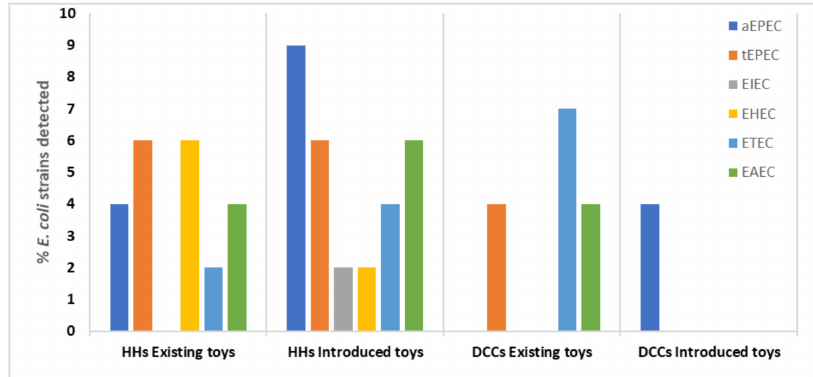
Figure 3. Prevalence of pathogenic E. coli strains found on existing and introduced toys (Excluding data from 2 DCCs who withdrew from study; Keywords: EAEC = enteroaggregative E. coli , aEPEC = atypical enteropathogenic E. coli , tEPEC = typical enteropathogenic E. coli , EHEC = enterohemorrhagic E. coli , EIEC = enteroinvasive E. coli